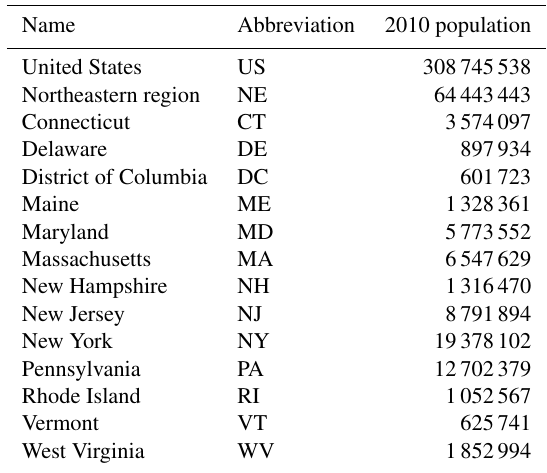
Table 1. Summary of the states that comprise the northeastern re- gion as defined by the National Climate Assessment (USGCRP, 2018). State abbreviations and population from the 2010 US Census are also given (U.S. Census Bureau,